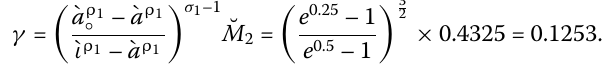
(cid:25) ` ι H ( ` a , ξ ) (cid:2) ( ξ ) d ξ , ` a